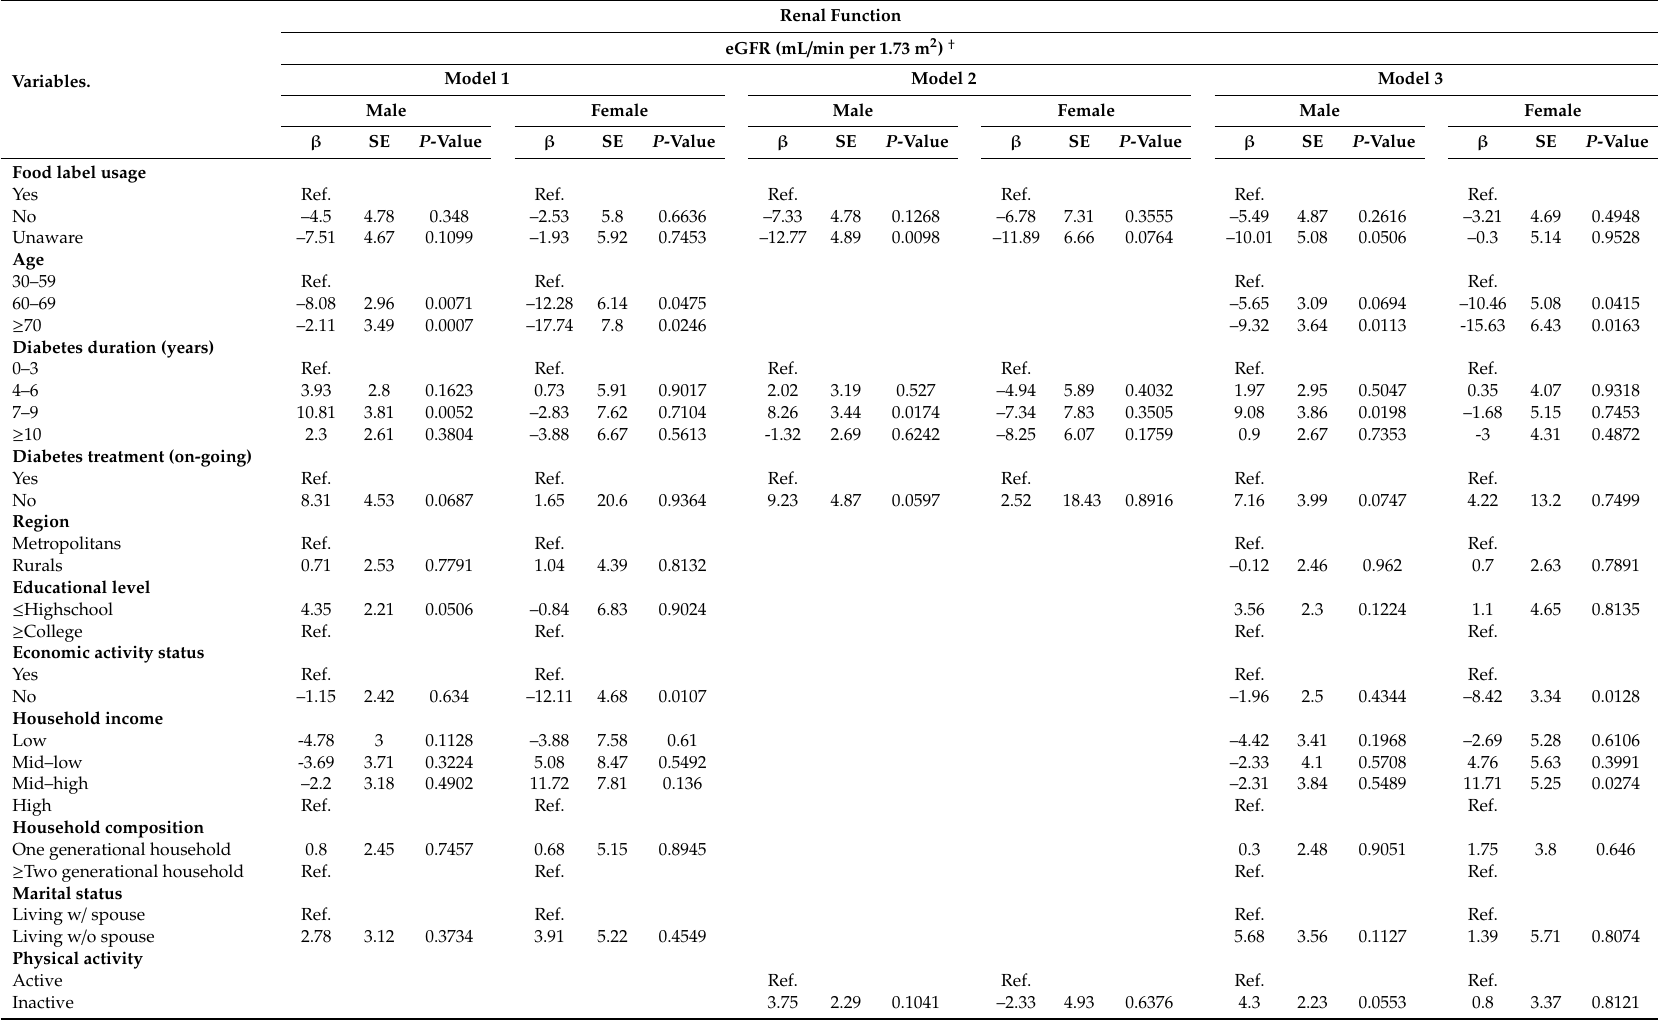
Table 2. Multiple regression analysis for renal